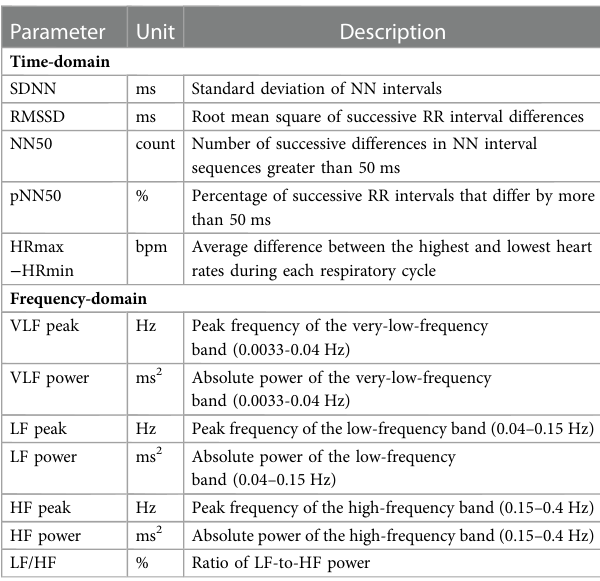
TABLE 1 Main measures of heart rate variability time- and